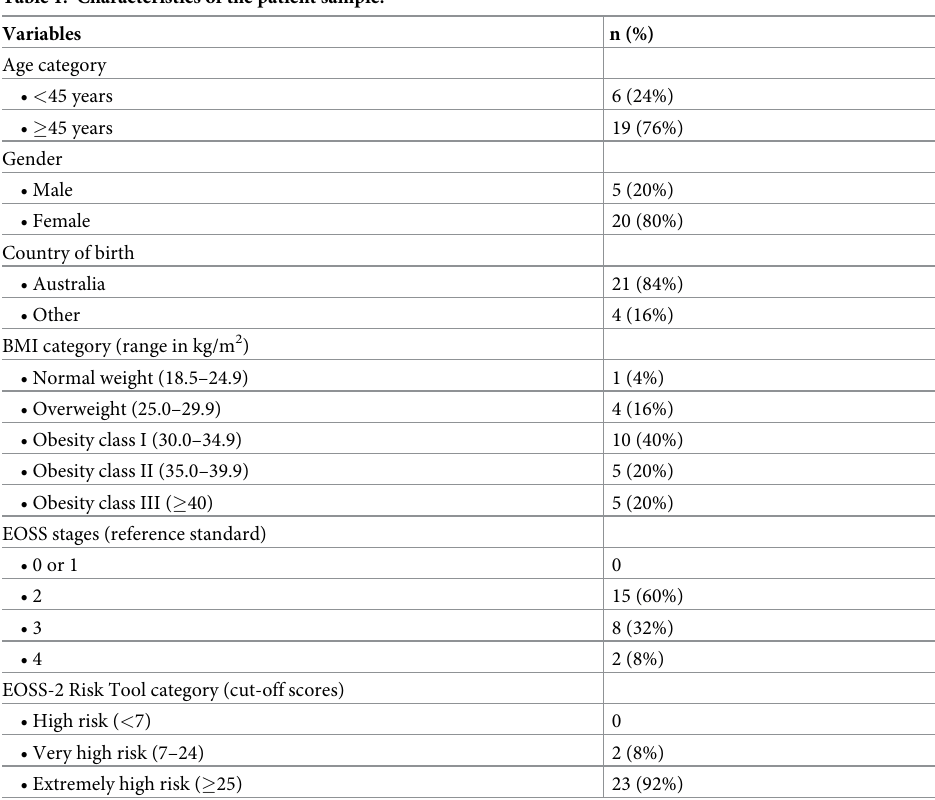
Table 1. Characteristics of the patient